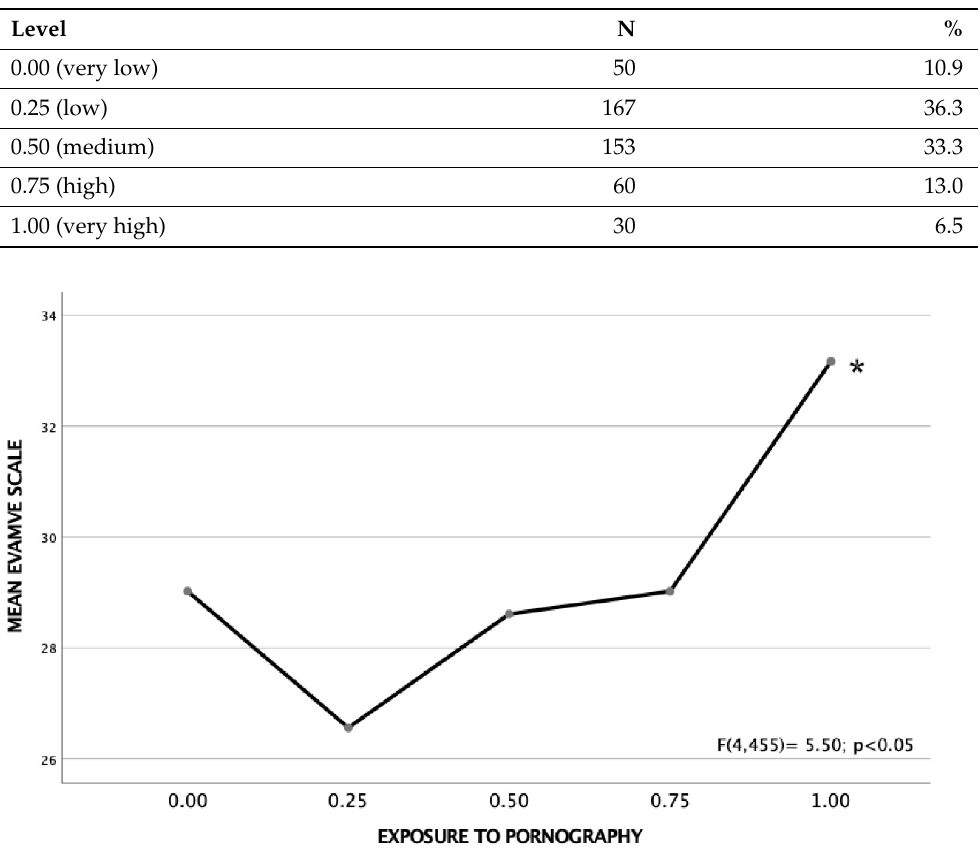
Figure 1. Mean of the EVAMVE scale according to the degree of exposure to pornography (minimum 0, maximum 1). The higher the score, the greater the explicit sexist attitudes, and violence and gender stereotypes. (* Marks the group that presents significant differences from the rest of the groups; Tukey’s HSD ( p < 0.05).